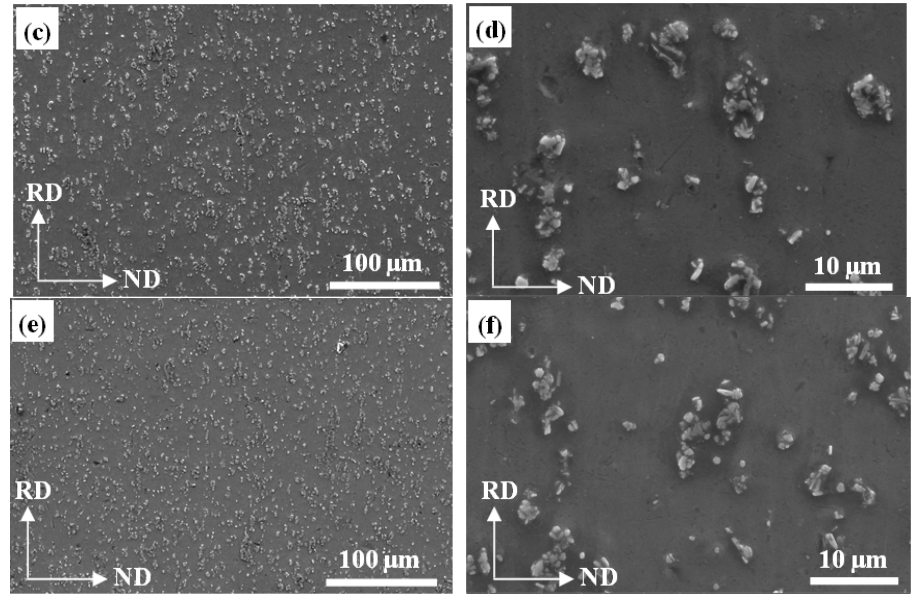
Figure 5. Microstructure evolution of Al-TiB 2 /TiC in situ composites with increased ARB passes in RD-ND plane: ( a , b ) One cycle; ( c , d ) Two cycles; ( e , f ) Four cycles.